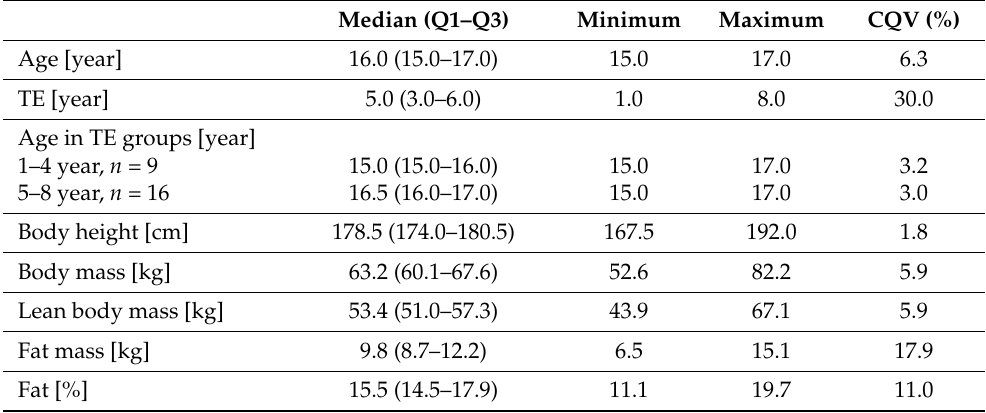
Table 1. Characteristics of studied